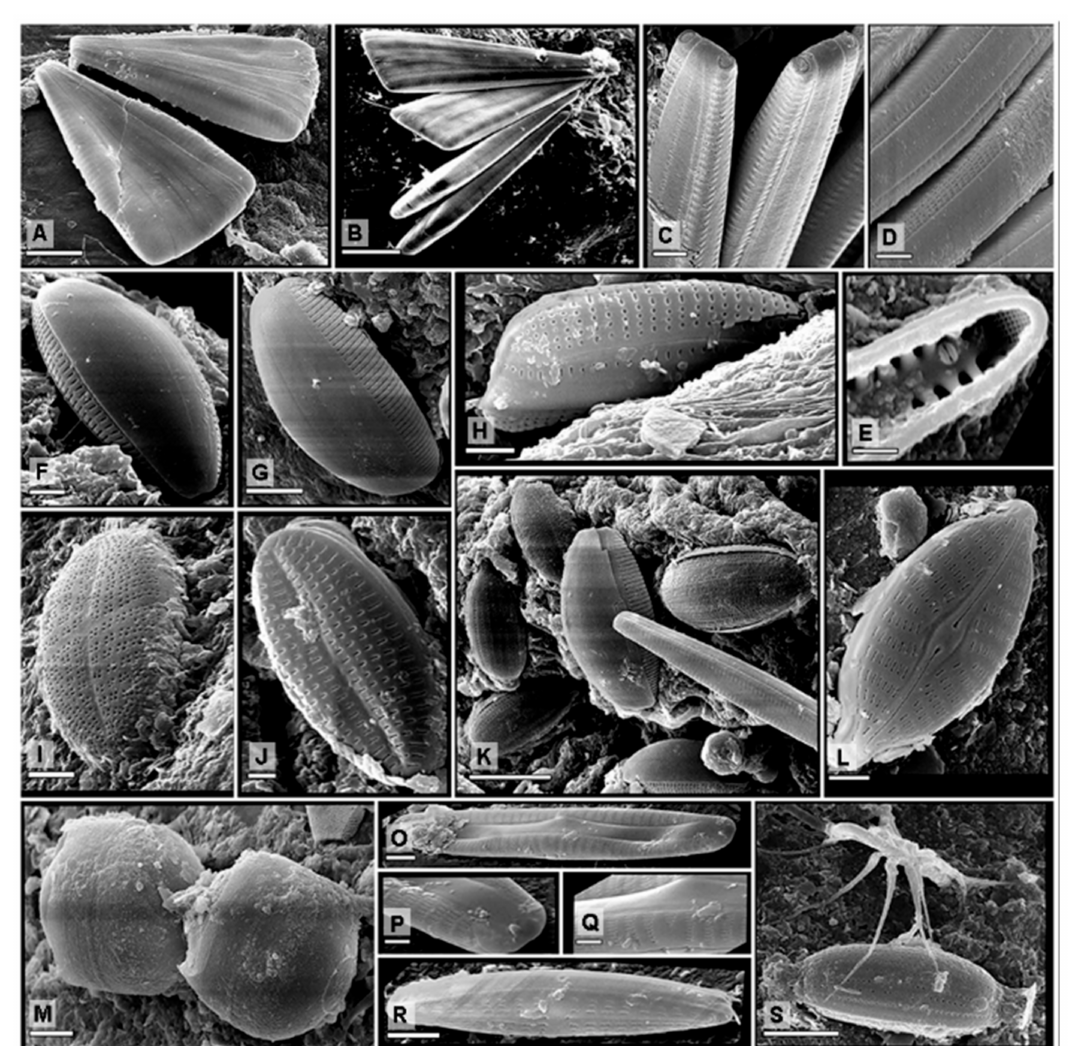
Figure 2. Diatoms found on fouling amphipods in south Brazilian estuaries. ( A ) overall view of two frustules of Licmophora abbreviata (scale: 10 µ m); ( B ) four cells attached by short mucilage stalks of Licmophora ehrenbergii (scale: 20 µ m); ( C , D ) details of frustules showing the ocellulimbus at the apices of Tabularia affinis (scale: 2 µ m) and ( E ) internal view of valve apex with rimoportula (scale: 1 µ m); ( F ) lateral view of a frustule of Amphora pediculus (scale: 2 µ m); ( G ) lateral view of a frustule of Amphora helenensis (scale: 5 µ m); ( H ) Rhoicosphenia marina (scale: 2 µ m); ( I ) Frustule attached by mucilage extruded through the raphe of Cocconeis dirupta (scale: 2 µ m); ( J ) Frustule attached by mucilage extruded through the raphe of Cocconeis sp. 1 (scale: 1 µ m); ( K ) Amphora , Halamphora, and Tabularia (scale: 10 µ m) on a gill of Paracaprella pusilla ; ( L ) Frustule in valve view, with a central raphe system of Navicula platyventris (scale: 2 µ m); ( M ) Melosira moniliformis (scale: 5 µ m); ( O ) Navicula sp.1 (scale: 2 µ m) with ( P , Q ) two details of apical and central regions (scale: 1 µ m); ( R ) Navicula sp. 2 (scale: 2 µ m); ( S ) Frustule in girdle view of Halamphora coffaeiformis (scale: 5 µ m) covered by a seta of P.